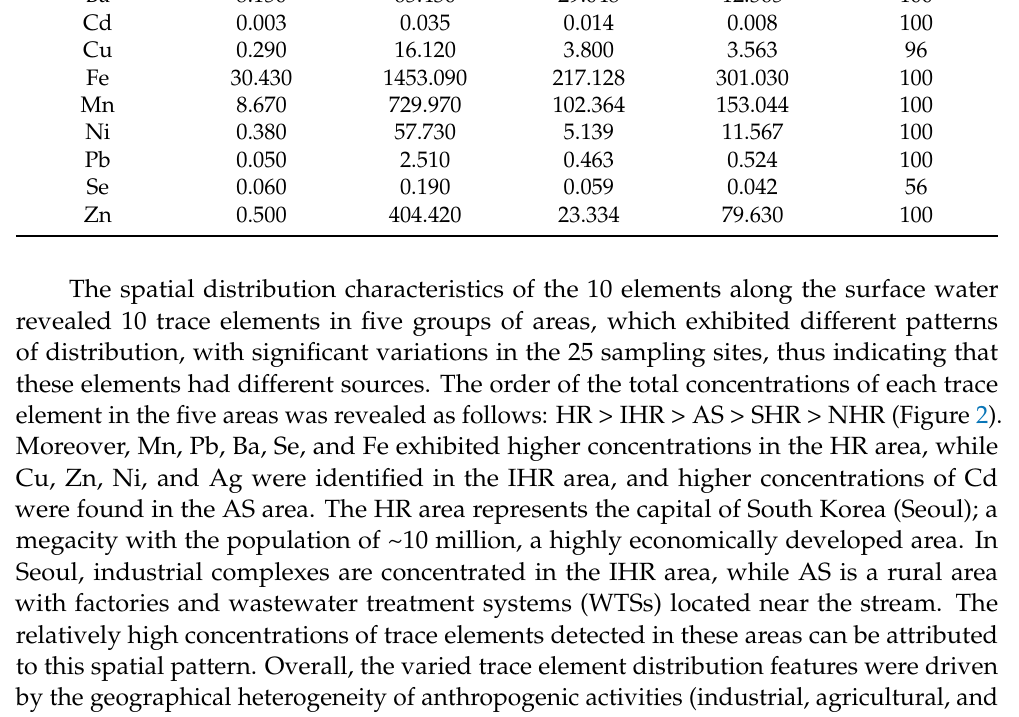
Min Max Conc. Conc. ( µ g/L) ( µ